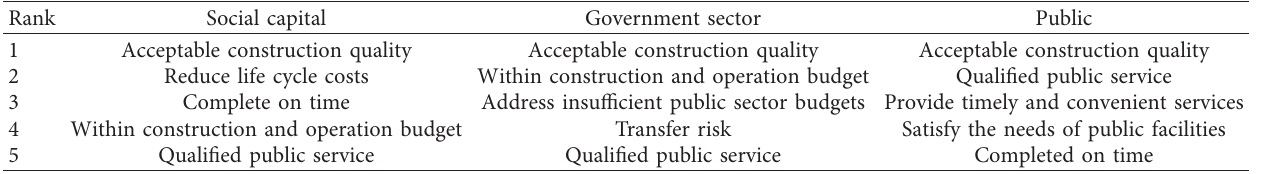
Table 1: Interest requirements on projects from